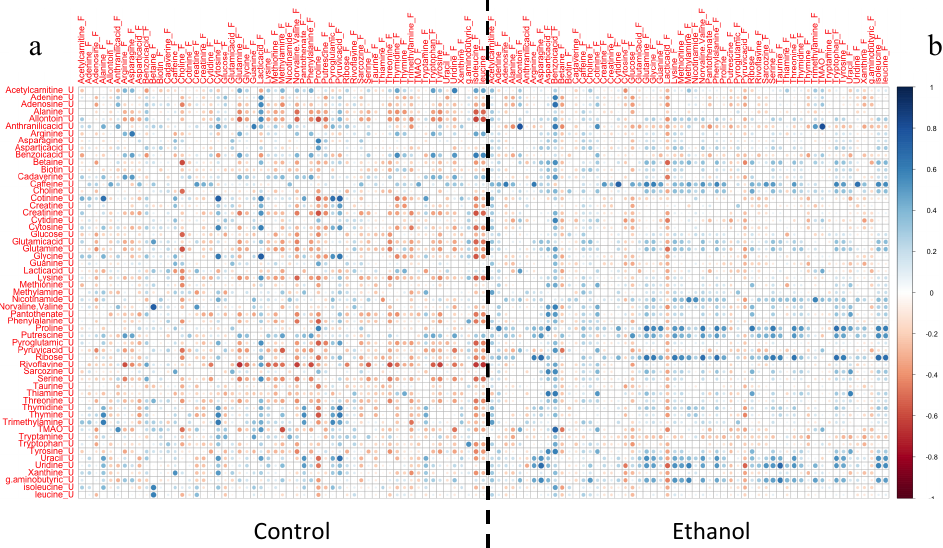
Figure 1. Pearson correlation heatmaps for the commonly detected metabolites in urine (U) and fecal (F) samples exhibiting the correlation pattern between the urinary and the fecal metabolome in ( a ) the control mice and in ( b ) the ethanol treated mice.